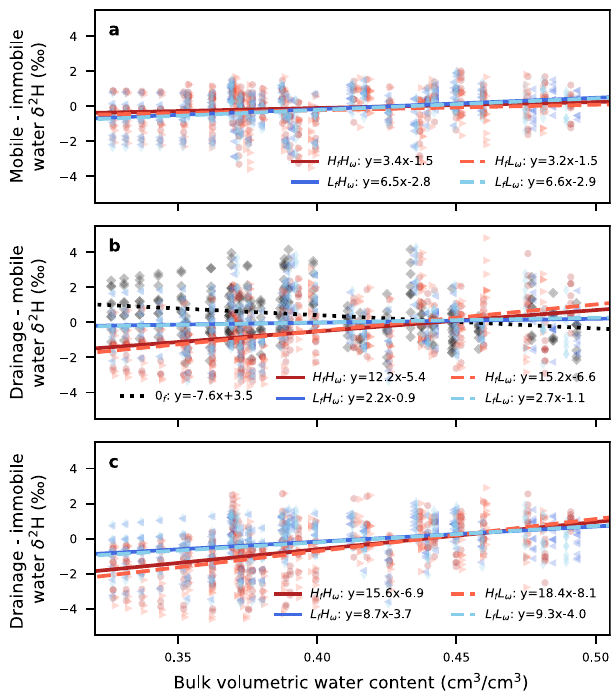
Fig. 2 | Isotope separation during different soil moisture conditions. The instantaneous isotopic separation for 10 simulations expressed as the δ 2 H differ- ence in a isotopic composition of the mobile and immobile pore space water at different volumetric water contents for models with high and low immobile frac- tions ( H f and L f ) and transfer rates ( H ω and L ω ). The separation in the isotopic composition of the drainage from the column and b mobile soil water and c immobile water at different water